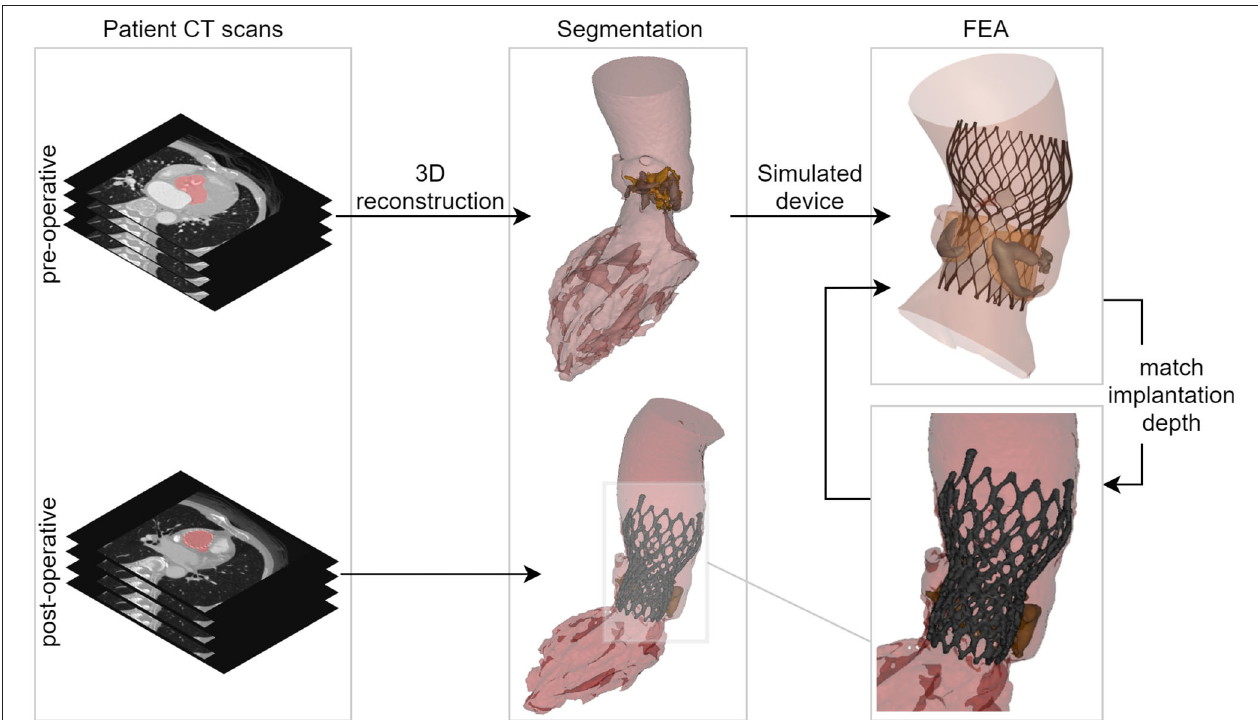
FIGURE 1 | Overview showing the main steps of the virtual insertion of a Venus A-valve in patient-specific geometry derived from pre-operative CT, while aiming for a virtual implantation depth identical to the actual one. CT, computed tomography; 3D, three-dimensional; FEA, finite element analysis.